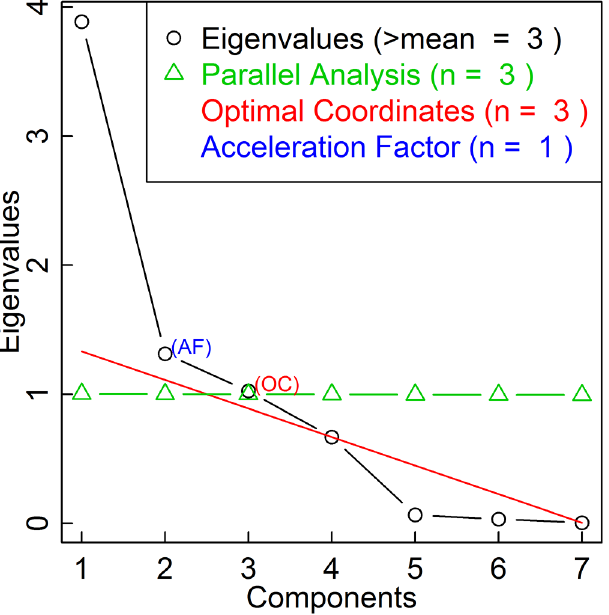
Fig 1. Determining the Number of Factors. Data sourced from Thomson Reuters Web of Science Core